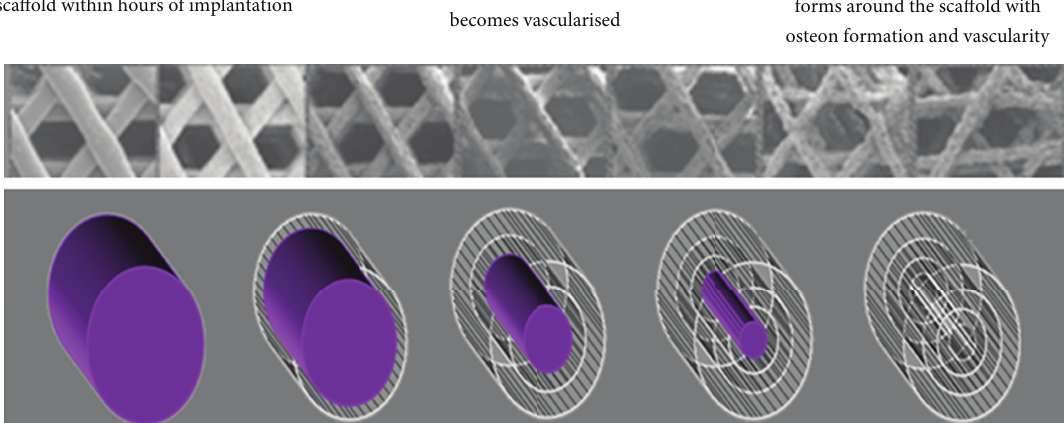
F 1: Schematic illustrating the interdependence of molecular weight loss and mass loss of a slow-degrading composite scaffold plotted against time. Scaffold implanted at with lower �gures showing a conceptual illustration of the biological processes of bone formation over time. A�er implantation the scaffold is immediately �lled with haematoma followed by vascularisation. �ew bone is formed gradually within the scaffold. As the scaffold degrades over time, there is increased bone remodelling within the implant site until the scaffold pores are 𝑡𝑡 𝑡 𝑡 entirely �lled with functional bone and vascularity (partially adapted from �2�). �e lower part of the �gure shows the schematic visualisation of how medical-grade poly-